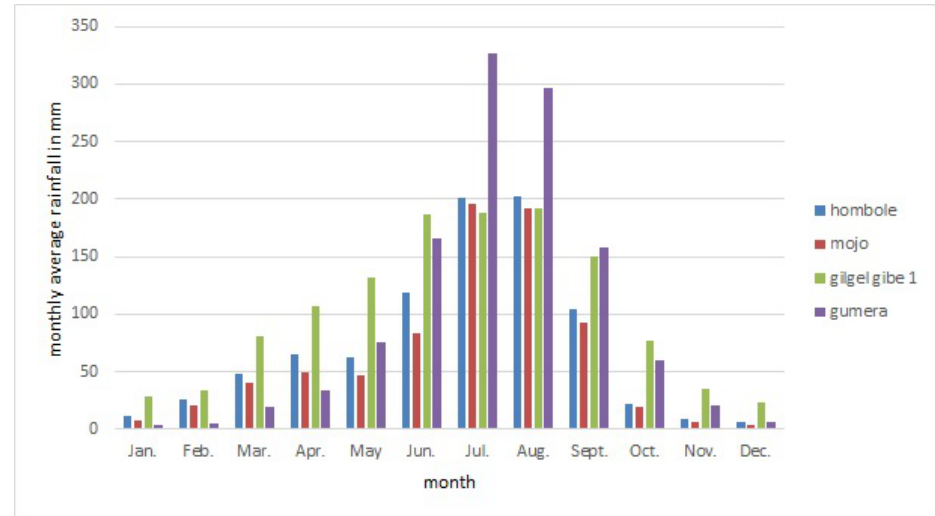
Figure 2. Monthly average rainfall of each watershed under consideration.